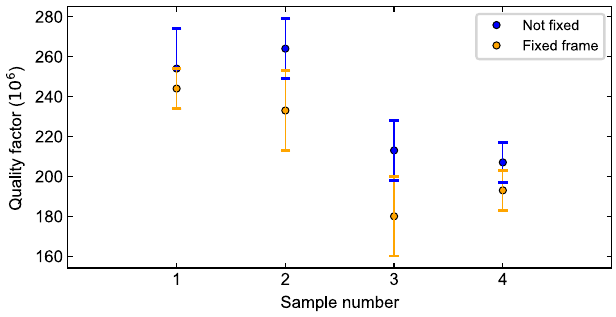
FIG. 13. Effect of chip mounting on the quality factor. Blue dots show the average measured Q when the chip is freely mounted on the sample holder and orange dots correspond to the average measured Q when fixing the chip tightly using metallic clamps pressing on the frame. Error bars show the standard deviation of four measurements for each